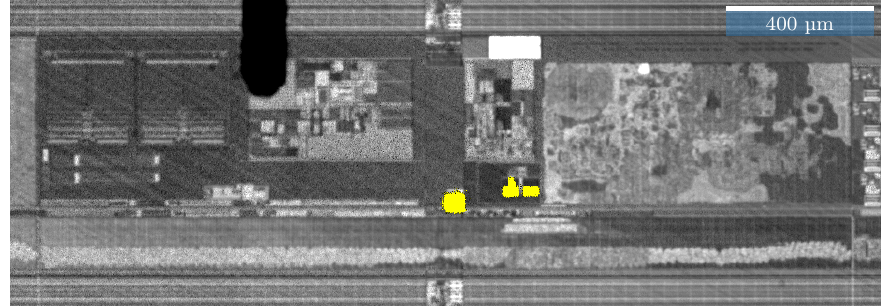
Figure 8: TLS measurements for key memory localization using the 5x lens.